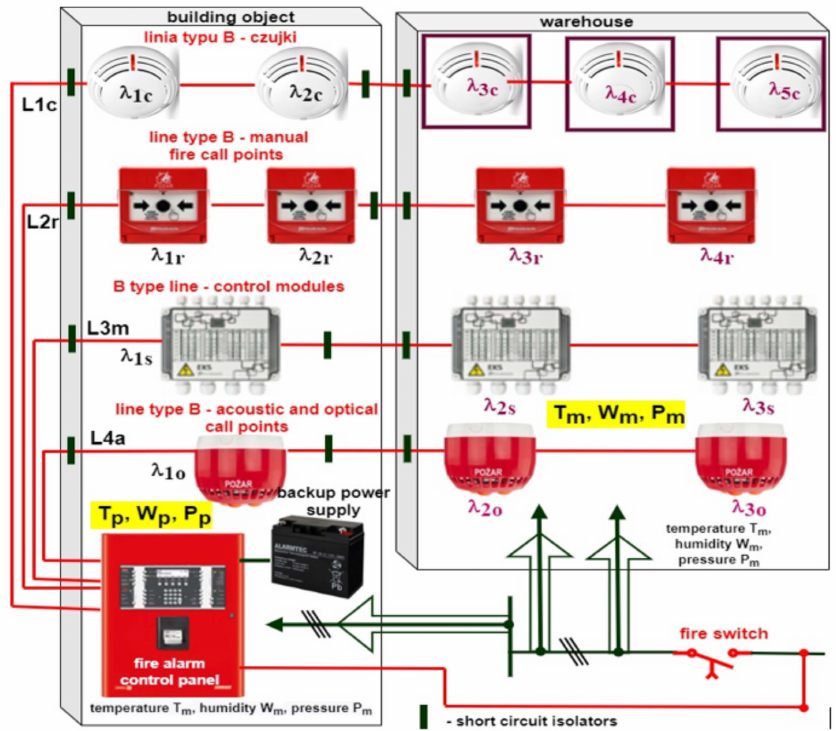
Figure 13. A focused FAS located in two different remote buildings—utility rooms, storage rooms, operation under various environmental conditions, where T pm —temperature, W pm —humidity, P pm